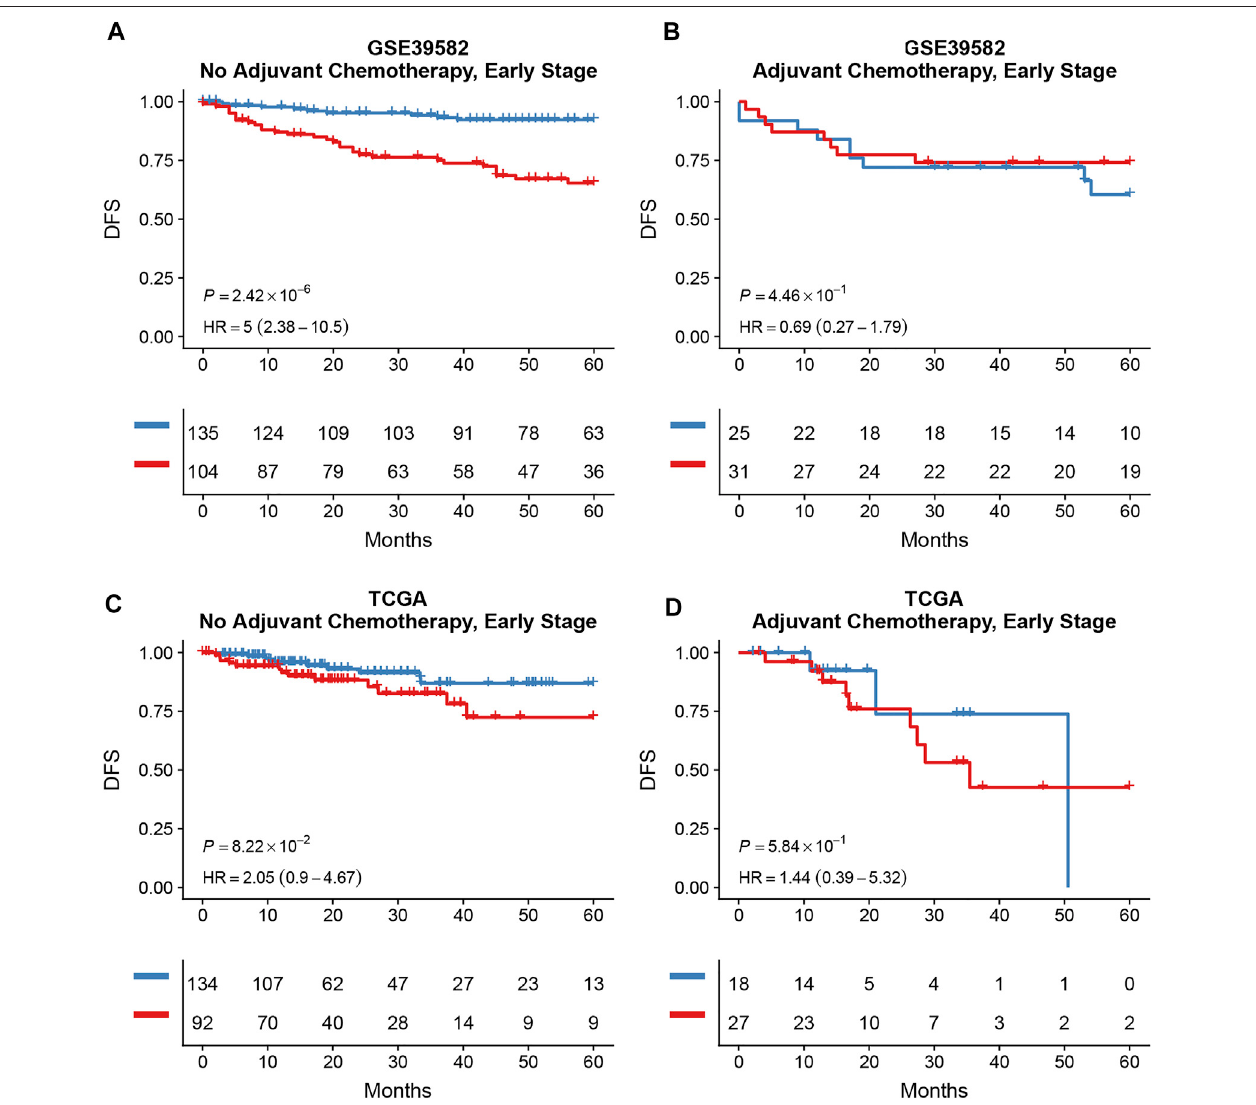
FIGURE 8 | Effects of adjuvant chemotherapy on DFS between different autophagy risk groups in early stage (stage I and II) patients with CRC. Kaplan – Meier curves showed DFS of early-stage patients between low and high autophagy groups with and without adjuvant chemotherapy respectively in the GSE39582 (A,B) cohort and the TCGA cohort (C,D) . p values comparing risk groups were calculated with the log-rank test.